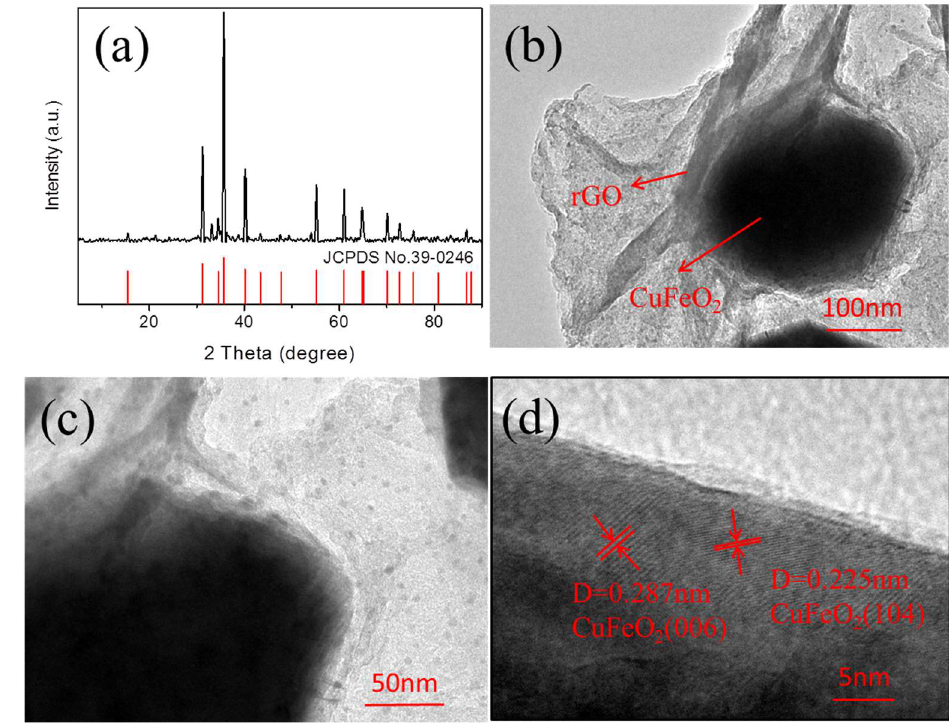
Figure 3. ( a ) XRD; ( b , c ) TEM images; and ( d ) HRTEM. In order to understand the specific surface area and pore structure of rGO-coated CuFeO 2 , nitrogen adsorption and desorption experiments were carried out. It can be seen from Figure 4a that the nitrogen adsorption/desorption isotherms of rGO-coated CuFeO 2 exhibited the III type with an H3 hysteresis loop, manifesting that the adsorbent-adsorbate interaction is weak. The H3 hysteresis loop is observed with aggregates of plate-like particles giving rise to slit-shaped pores [32], which is consistent with the morphology of rGO-coated CuFeO 2 . The BET specific surface area is calculated as 4.295 m 2 /g using the N 2 adsorption-desorption isotherms. The DFT pore diameter distribution curve is shown in Figure 4b, making it clear that the pores caused by particle accumulation are mainly micropores and mesopores. Figure 4. ( a ) Nitrogen adsorption-desorption isotherm and ( b ) pore size distribution. To further investigate the chemical composition and surface characteristics of the material, rGO-coated CuFeO 2 was analyzed by XPS, and the distinct peaks allocated to